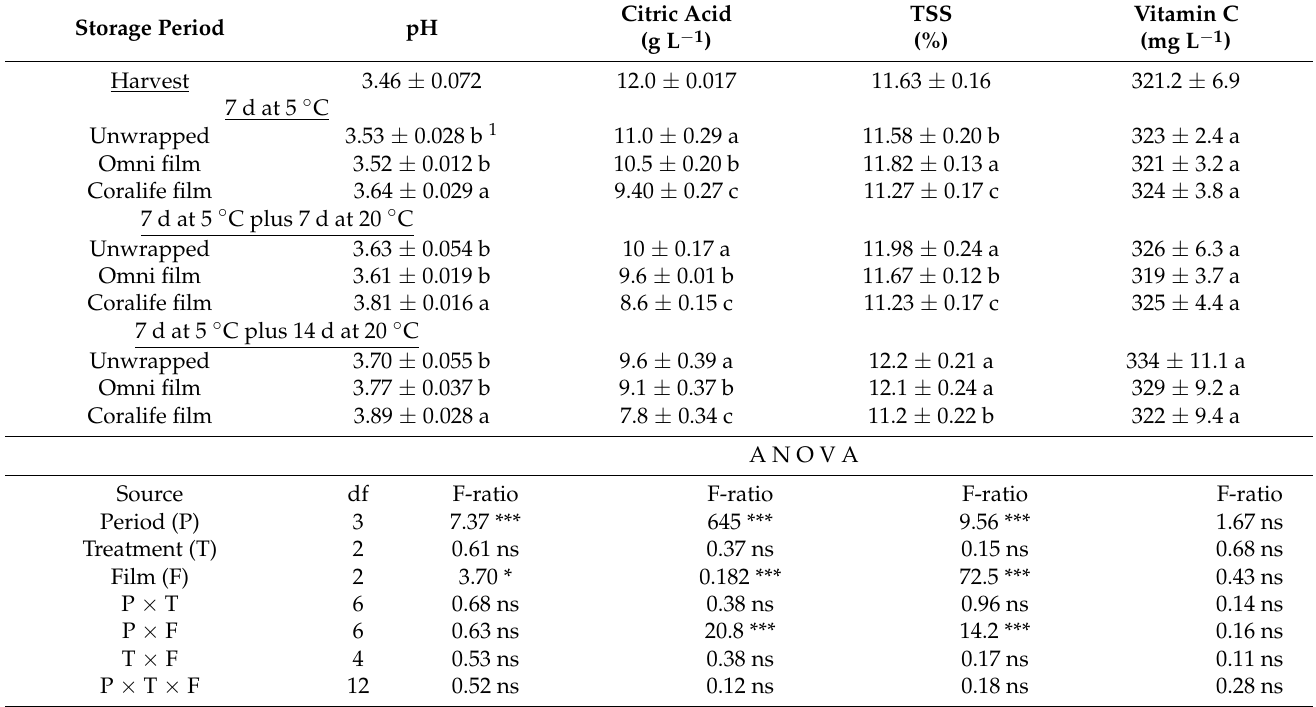
Table 3. Juice pH, citric acid, total soluble solids (TSS), and vitamin C content of ‘Simeto’ mandarins after seven days at 5 ◦ C and 85–90% RH, plus seven or fourteen days at 20 ◦ C and 55–60%